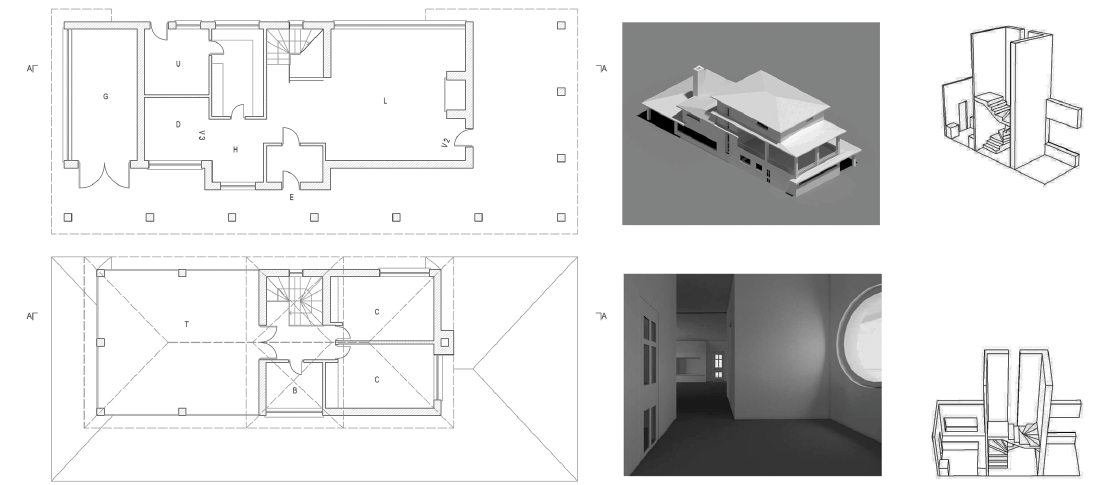
Figure 7. House 7. Plans, schemes, isometric view, perspectives (C. Gelardi).